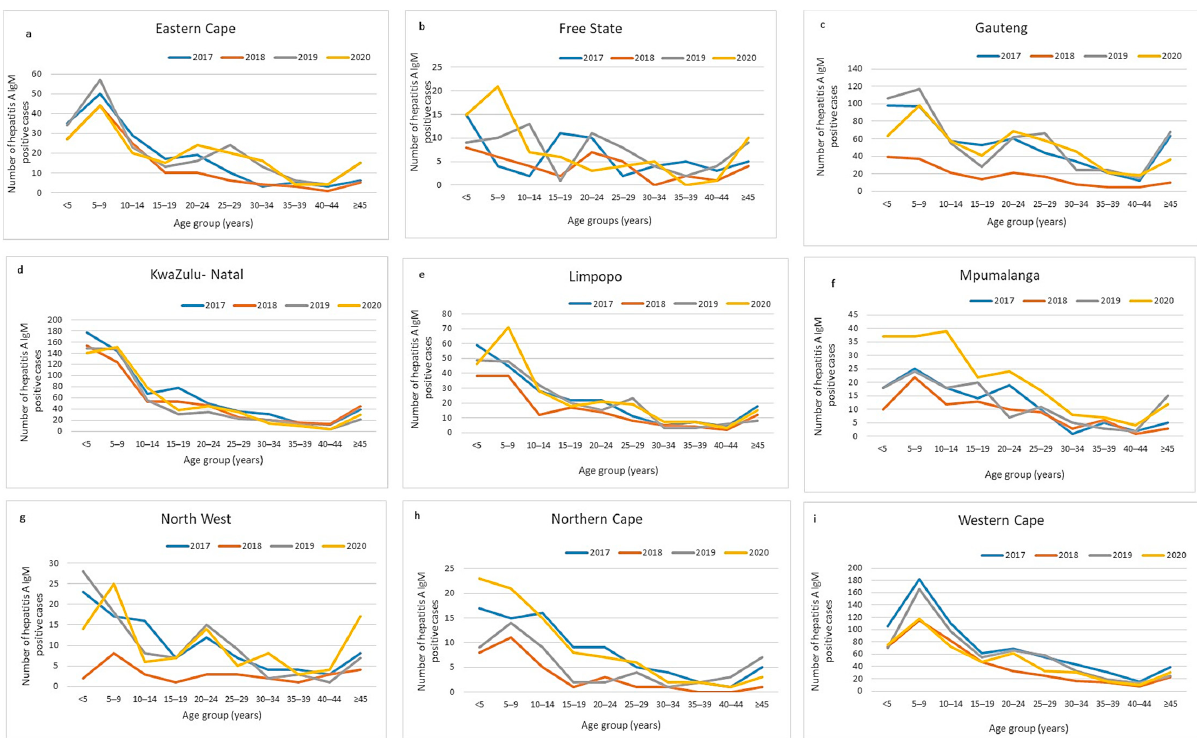
Figure 2. ( a – i ) Provincial age distribution of laboratory-confirmed hepatitis A cases, 2017–2020.